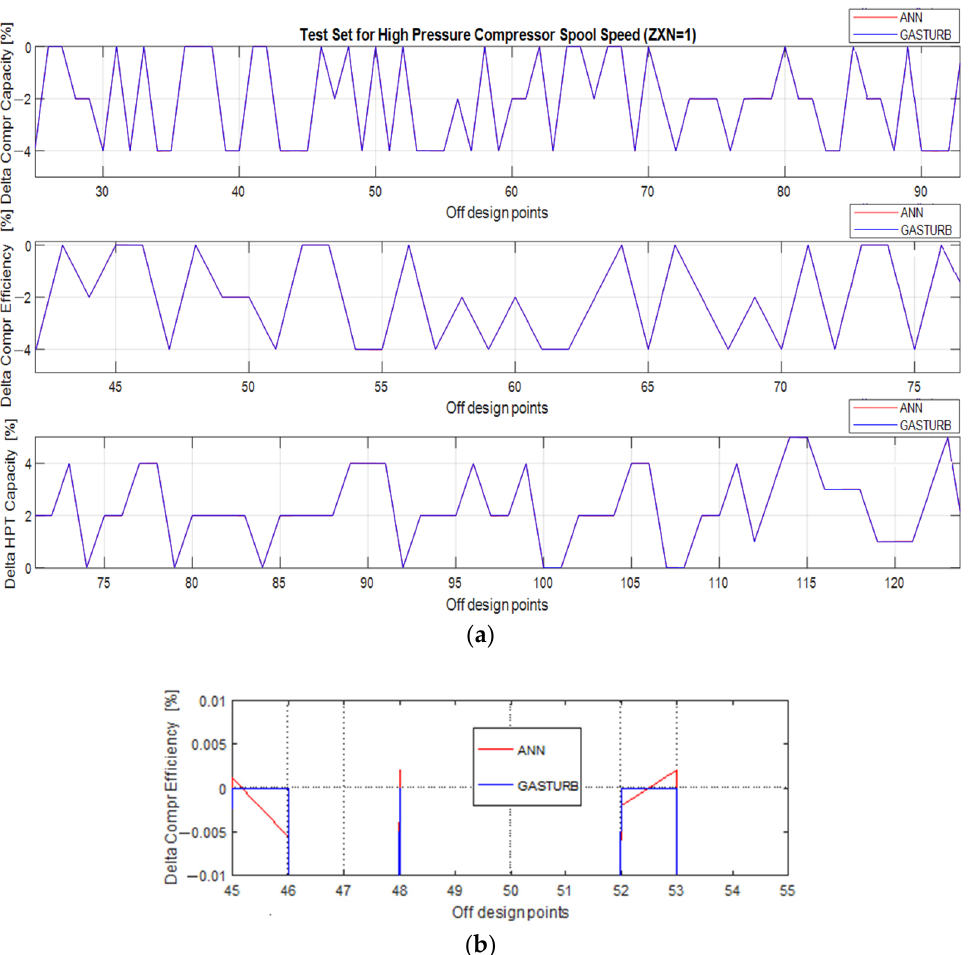
Figure 2. Original fault parameters and parameters simulated by ANN-based one regime diagnostic model (( a ) 3 parameters, normal scale; ( b ) compressor efficiency parameter, enlarged scale).